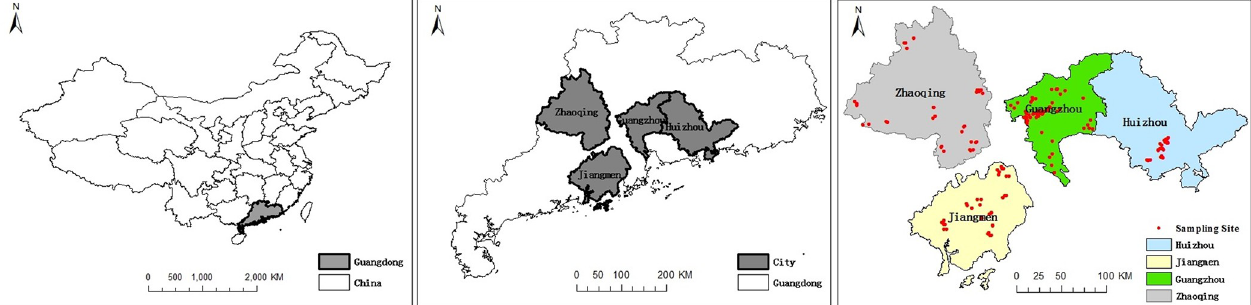
Fig 1. Map of study area with location of sampling sites (A, map of China; B, map of Guangdong province; C, map of sampling sites).